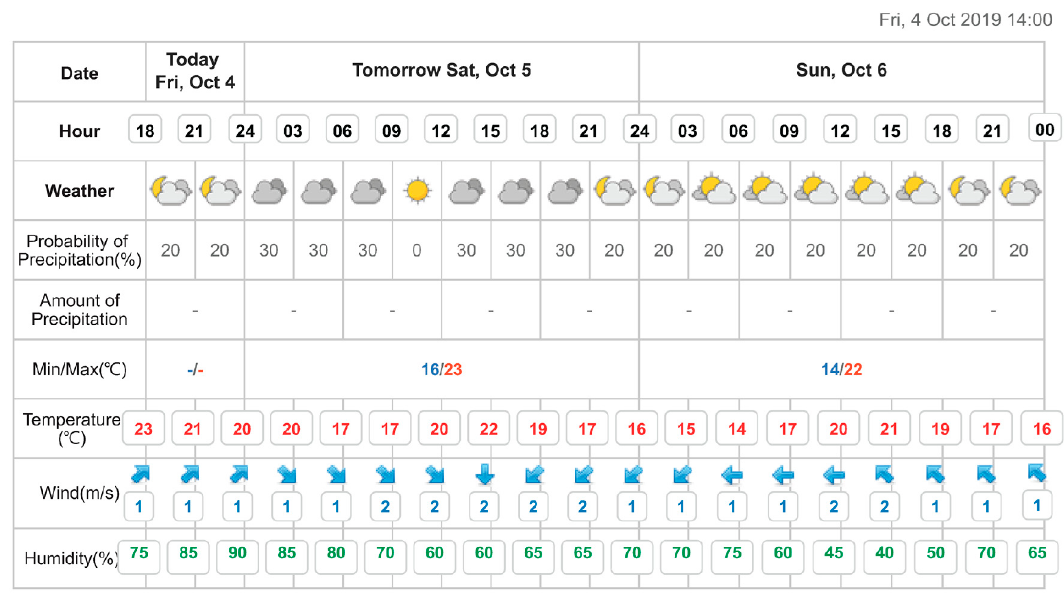
Figure 2. Example of short-term weather forecast information provided by KMA.